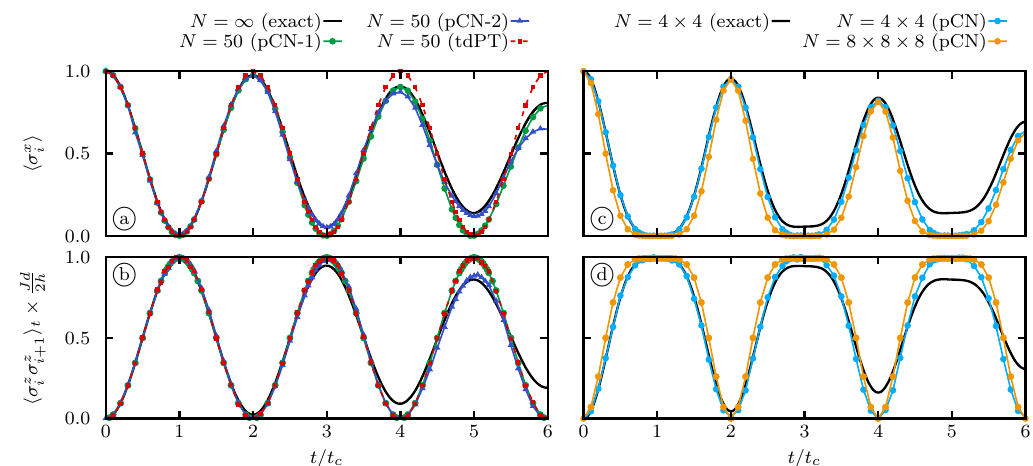
Figure 2: Time evolution of transverse magnetization (top panels) and nearest-neighbor correlation function (bottom panels) in the TFIM. (a, b) Results for d = 1 obtained from the pCN with first order (pCN-1) and second order (pCN-2) expansion in comparison with the exact dynamics and time-dependent perturbation theory (tdPT). (c, d) Dynamics in d = 2 (blue), and d = 3 (orange) obtained from the first order pCN compared to exact results in = π/ J d = 2. Data obtained with h / J = 0.05; t c